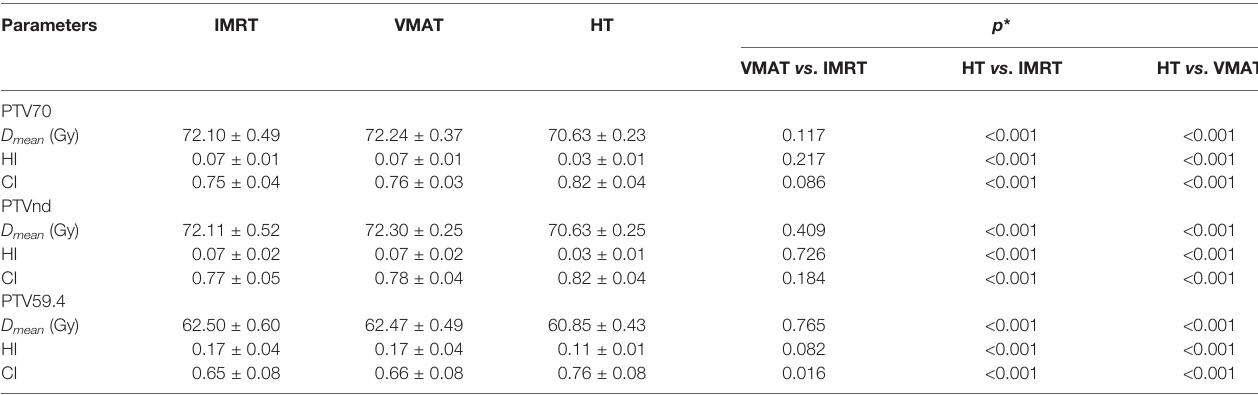
TABLE 3 | Dosimetric parameters for PTV of three